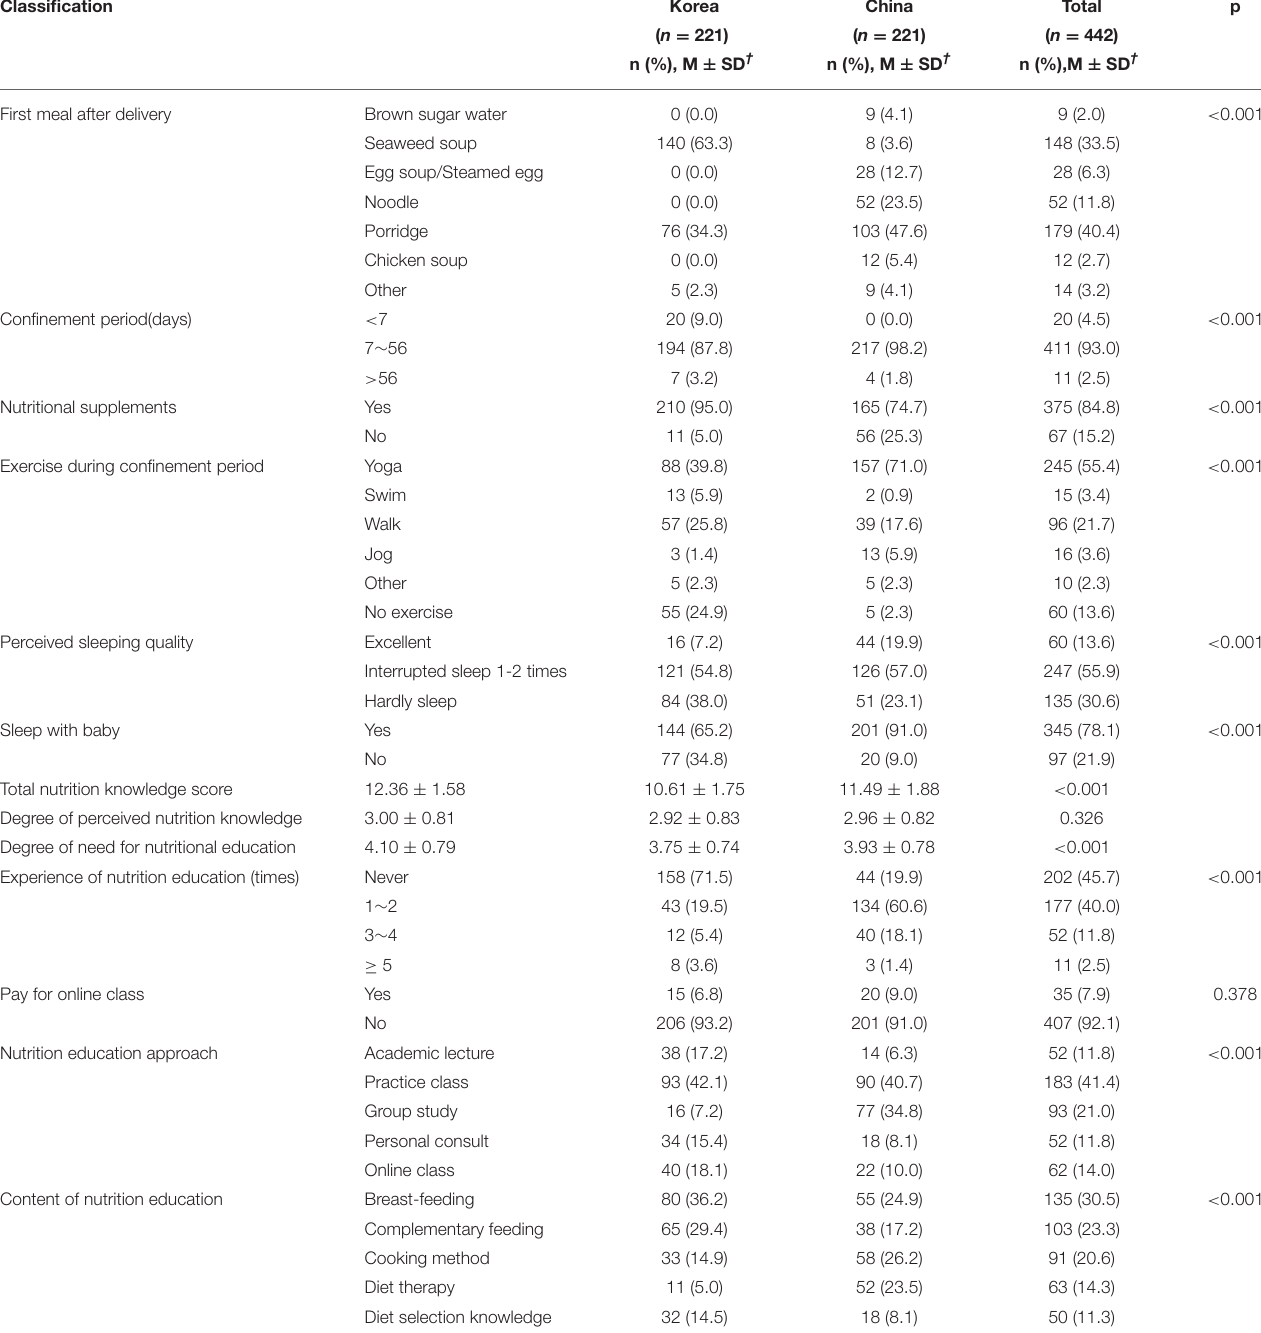
TABLE 2 | Comparison of confinement diet, behaviors after delivery, nutrition information sources and the need for nutrition education among Korean and Chinese postpartum women.